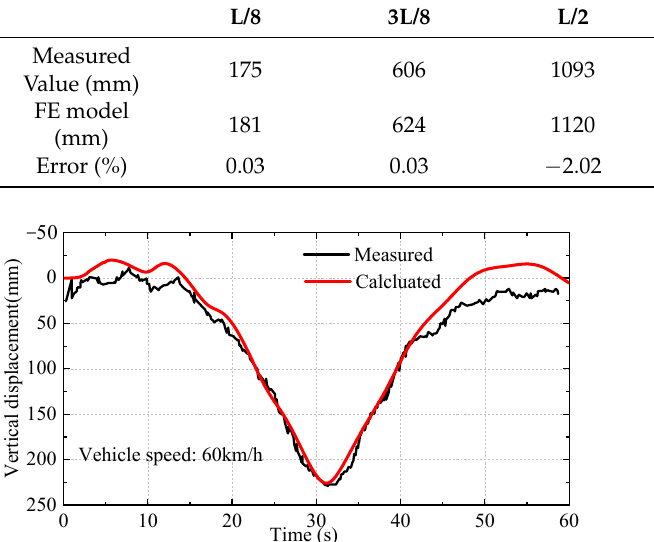
Table 1. Comparison of stiffening girder vertical deflection under static test.